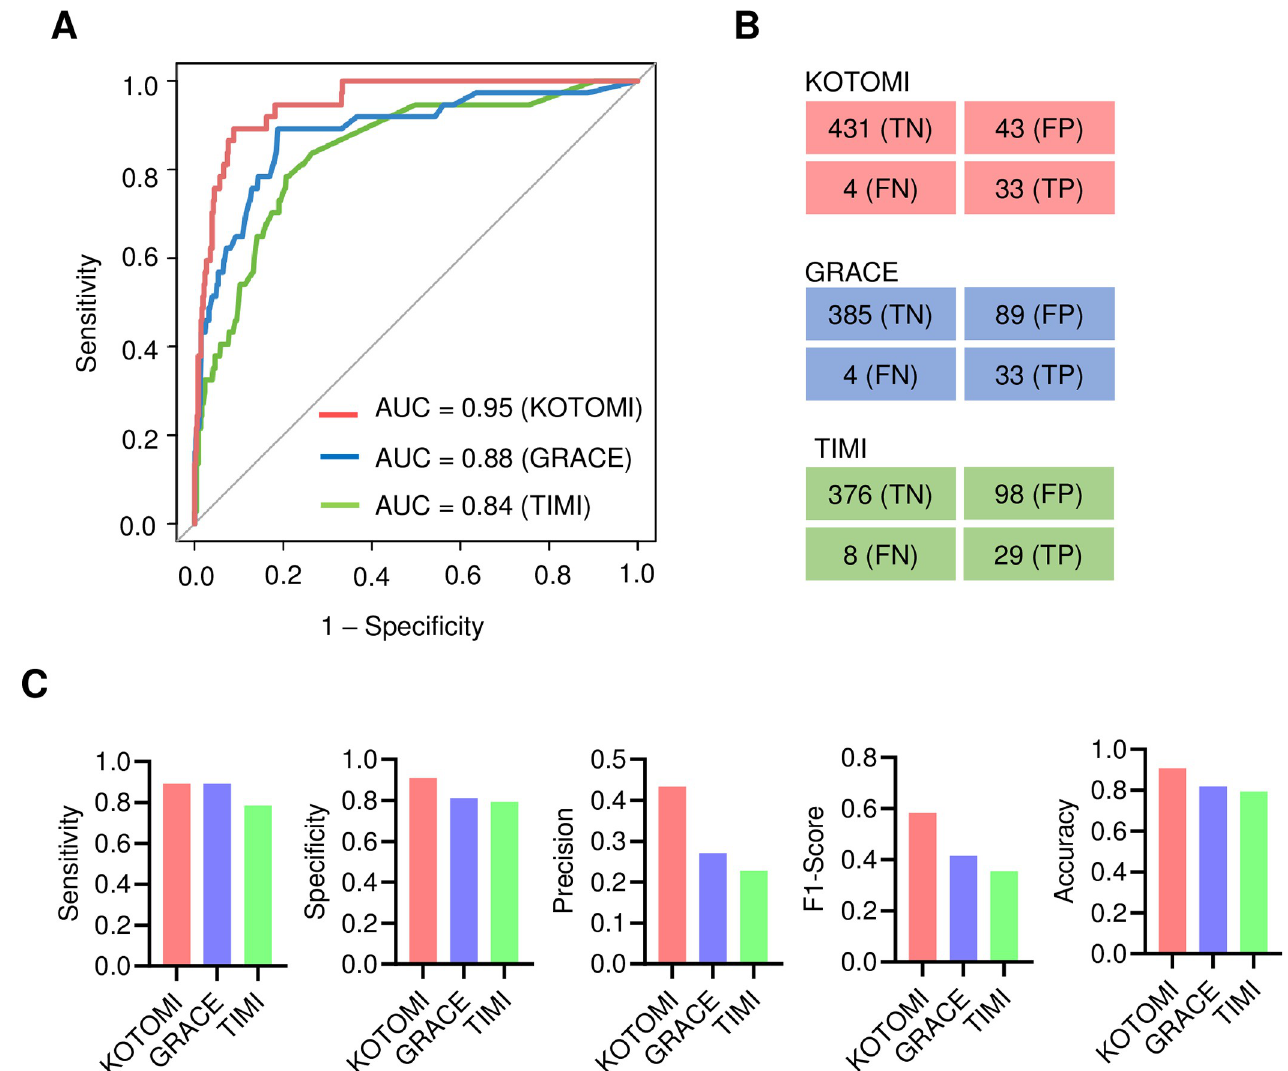
Fig 3. Model performance evaluation for test subset. A, Receiver operating characteristic (ROC) curve and its area under the curve (AUC) of KOTOMI, GRACE, and TIMI. B, Confusion matrix of each model was determined by the optimal threshold of the model, which discriminates death and survival by Youden’s index method for the ROC curve. C, Sensitivity, specificity, precision, F1-Score, and accuracy for KOTOMI, GRACE, and TIMI were calculated based on the confusion